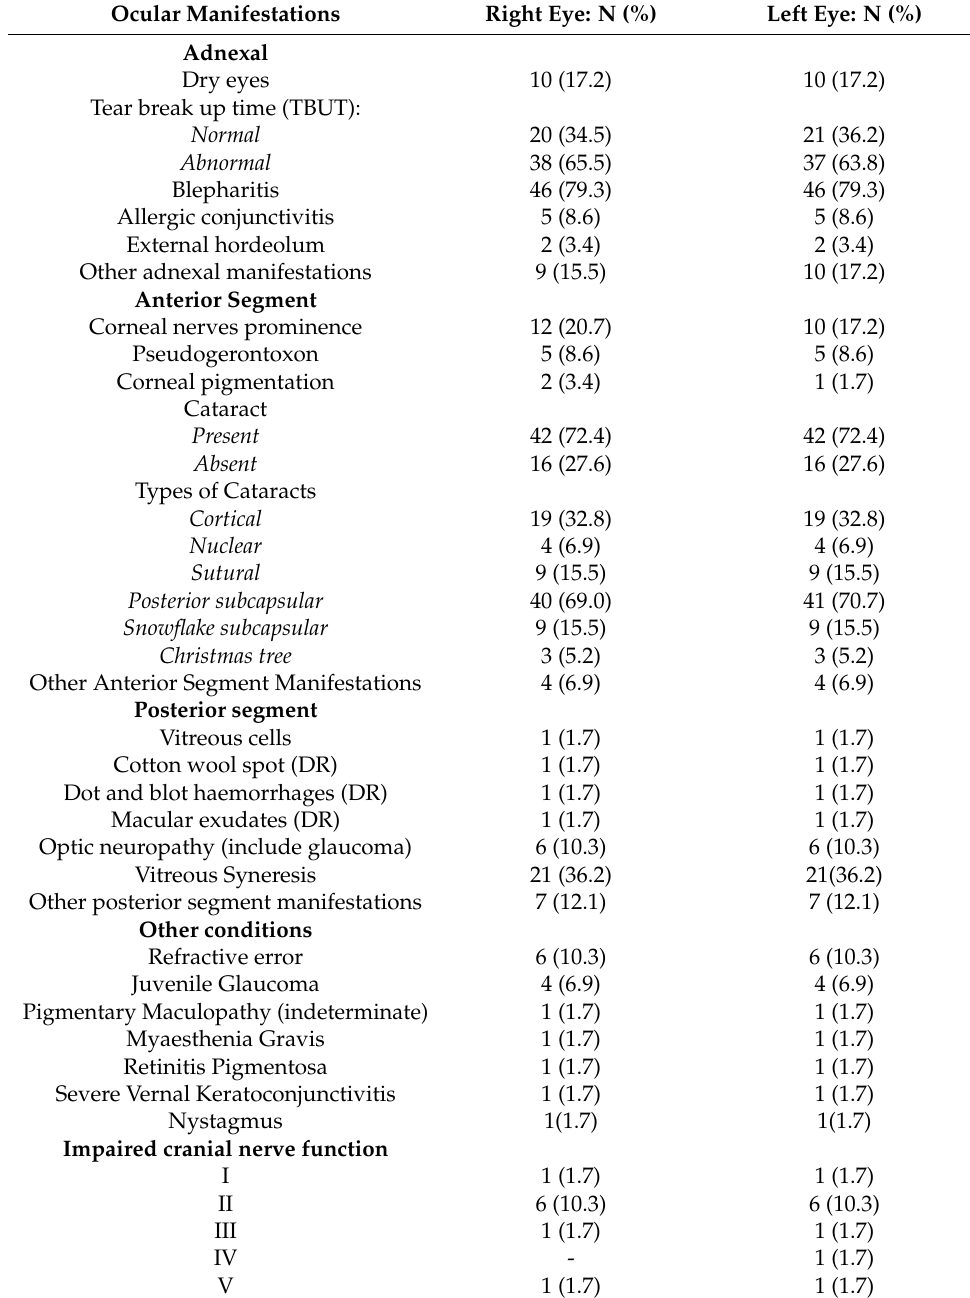
Tear Break Up Time = TBUT, N = Number, Diabetic Retinopathy =